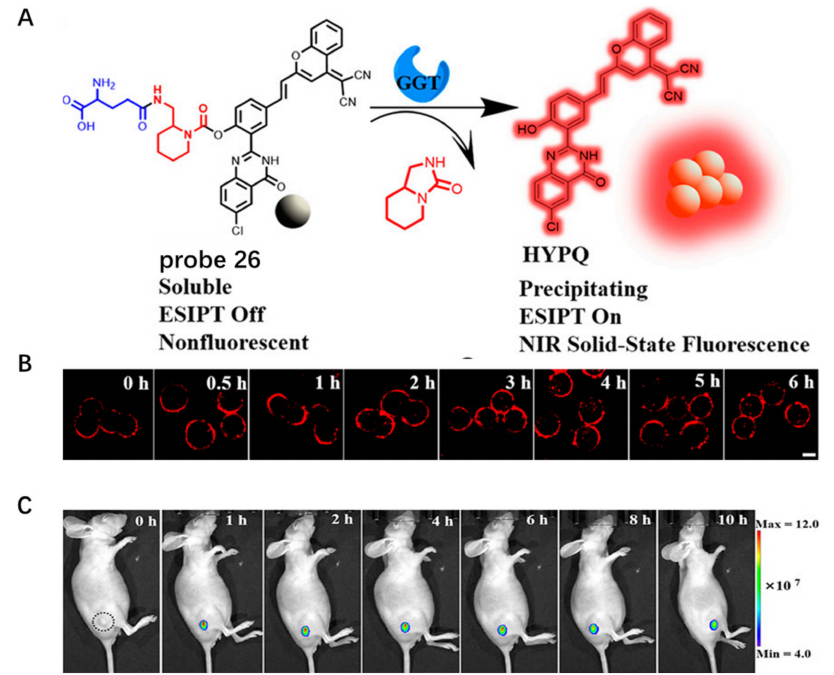
Figure 26. ( A ) Chemical structure of probe 26 and its response to GGT. ( B ) Long-term in situ im-ages of probe 26 in live cells. Scale bar: 20 µ m. ( C ) Long-term in situ imaging of GGT in tumors using probe 26 . Copyright 2021 National Academy of Sciences [87].